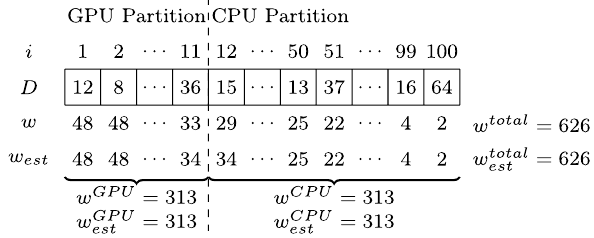
Fig. 5 Representation of the static partitioning strategy based on the candidate points, where D is the dataset, i the indices of the query points in D , the workload of the points w as used to sort them by their Total workload (and where w is the total number of candidate points to refine), and w est the workload of the query points determined by the total model (and where w est is the total estimated workload of HEGJ oin ). While we consider for this example that the model estimates a work- total = w Total load that is equal to the workload of HEGJ oin ( w ), there est total Total might be scenarios in which w are different. We consider est and w in this example that the model estimates the CPU and GPU to have the same throughput and thus assign the same number of estimated CPU = w GPU candidate points to refine to the CPU and to the GPU ( w est est ). Furthermore, as in this example the estimated workload is the same total = w Total as the actual workload of HEGJ oin ( w ), both processors est GPU = w CPU are assigned the same amount of work to compute ( w ), i.e., the same number of candidate points to